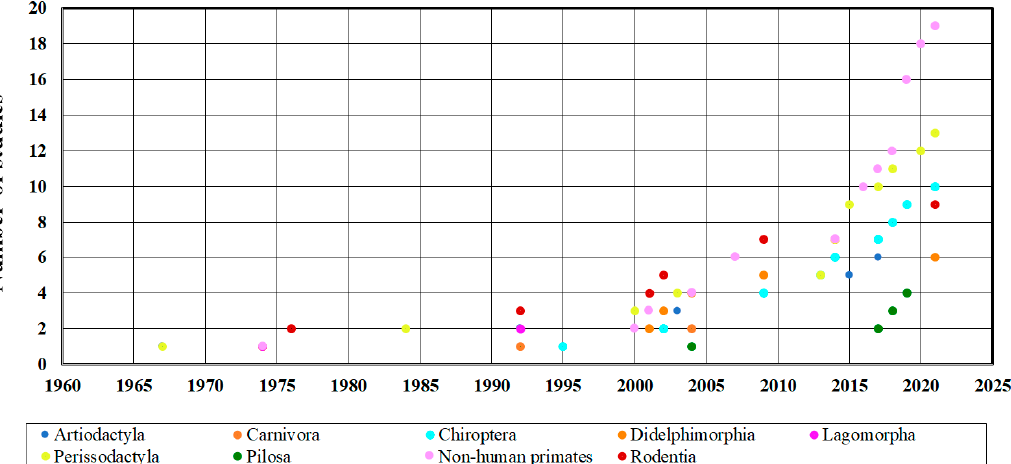
Figure 3. Sampling effort for arboviruses in the different orders of mammals in the Neotropics during the period 1967–2021 (n = 46).